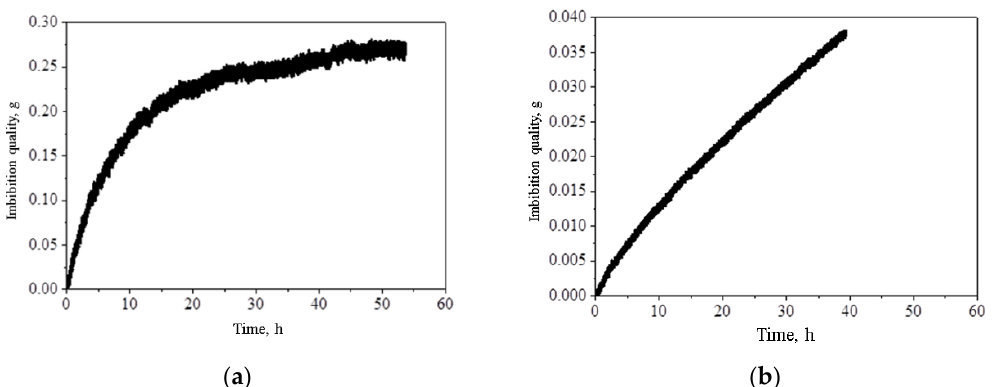
Figure 4. The time-dependent curve of fracturing fluid imbibition during shale imbibition. ( a ) The variation of imbibition capacity of N-8 during imbibition process, and ( b ) the variation of imbibition capacity of N-67 during imbibition process.